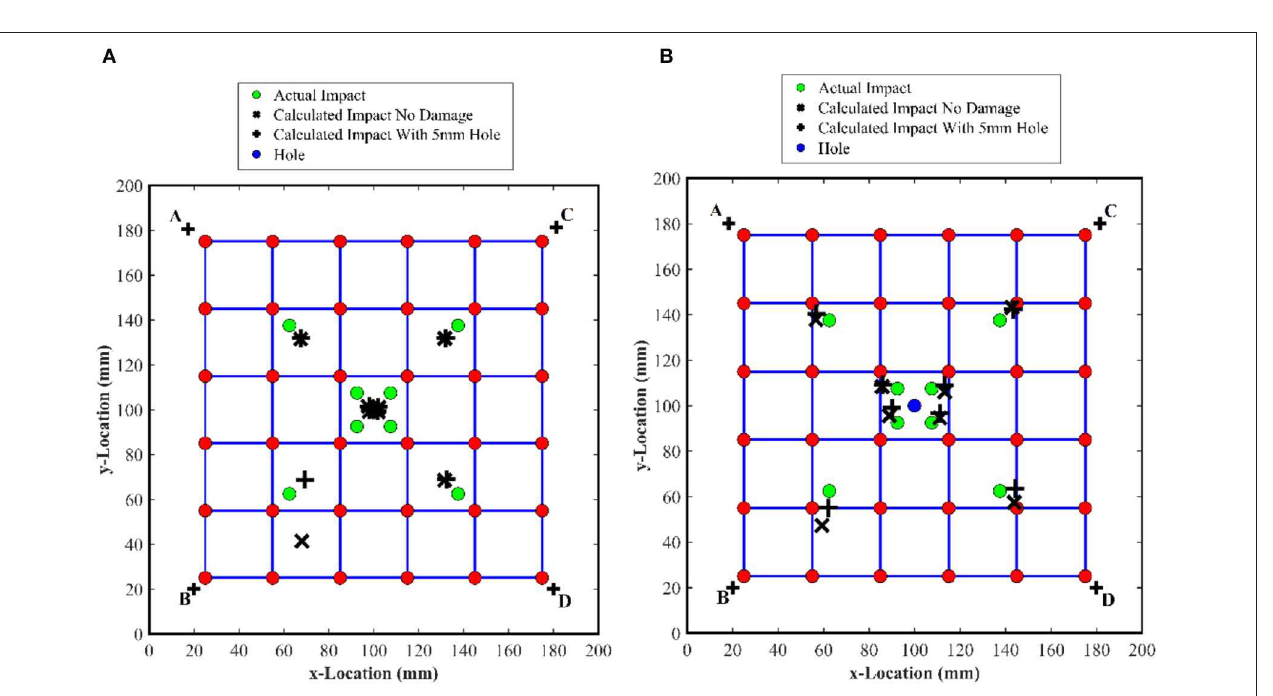
impact point “1” presented the lowest C TR values of the test, which were, 0.96, 0.92, and 0.96 for the sensor B, C, and D. For the other impact tests the index remained close to the